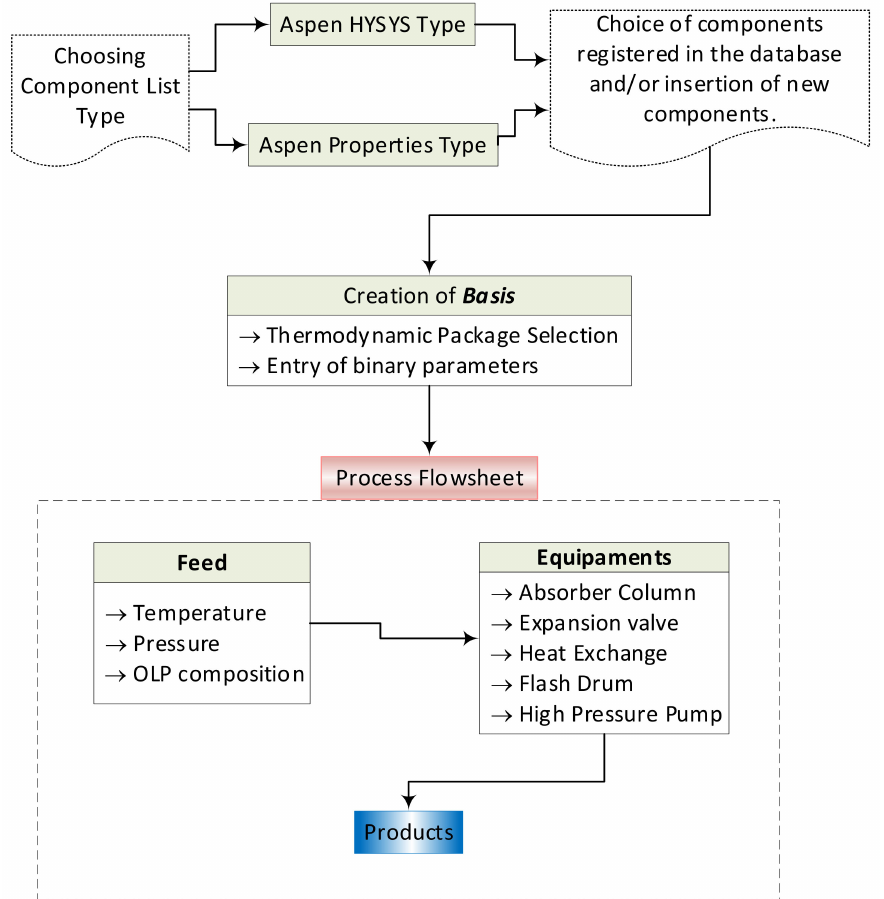
Figure 2. Process simulation steps using Aspen-HYSYS 8.4 for the deacidification/deoxygenation of OLP, as described elsewhere [59]: 1—the selection of the component list type; 2—the formulation of the list of components; 3—the basis formulation; 4—the flowsheet assembly of the